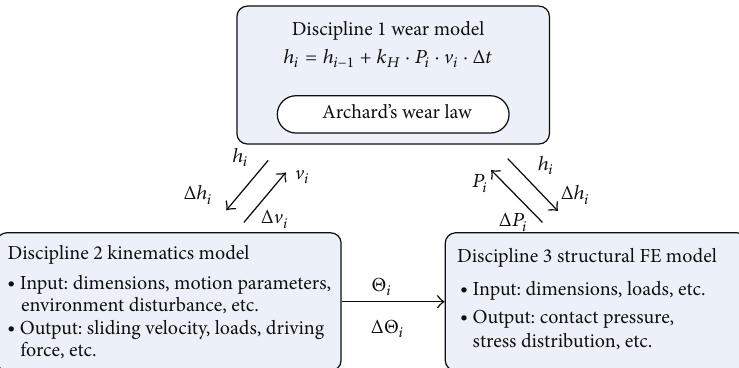
Figure 1: Schematic of the multidiscipline reliability model considering wear.